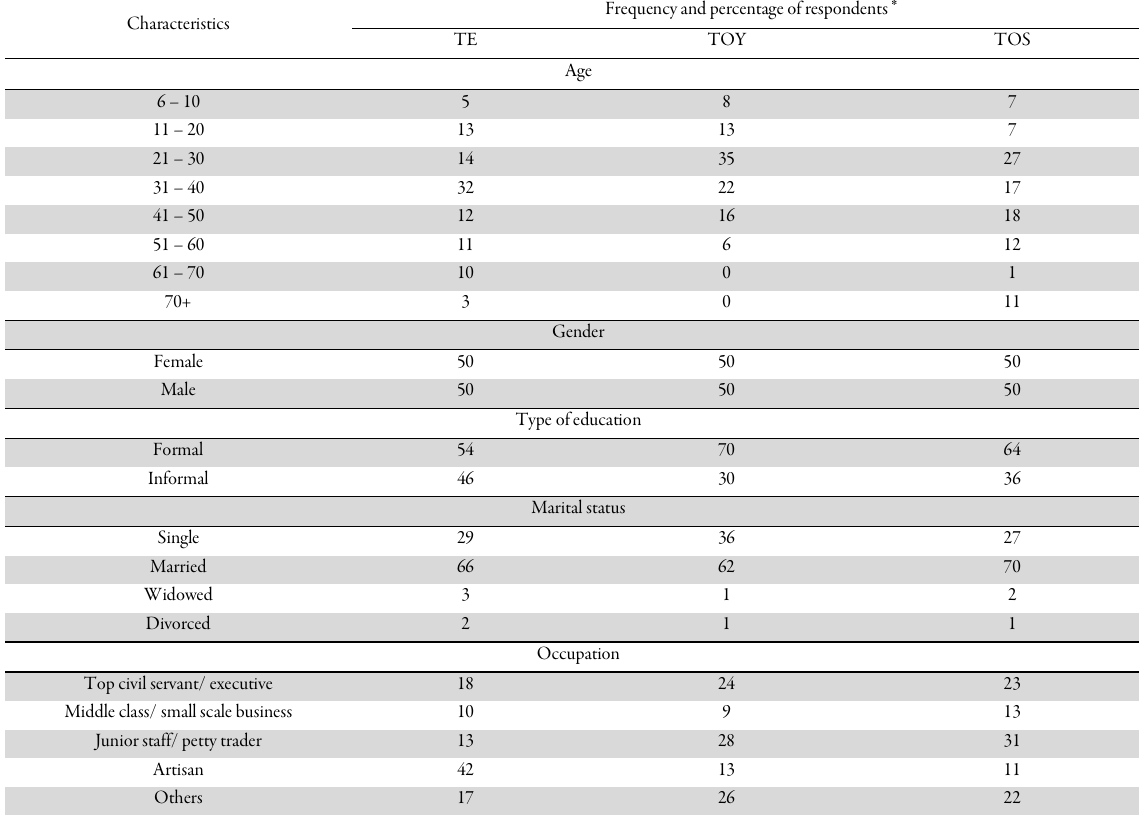
Table 1. Demographic characteristics of the subjects used in the study